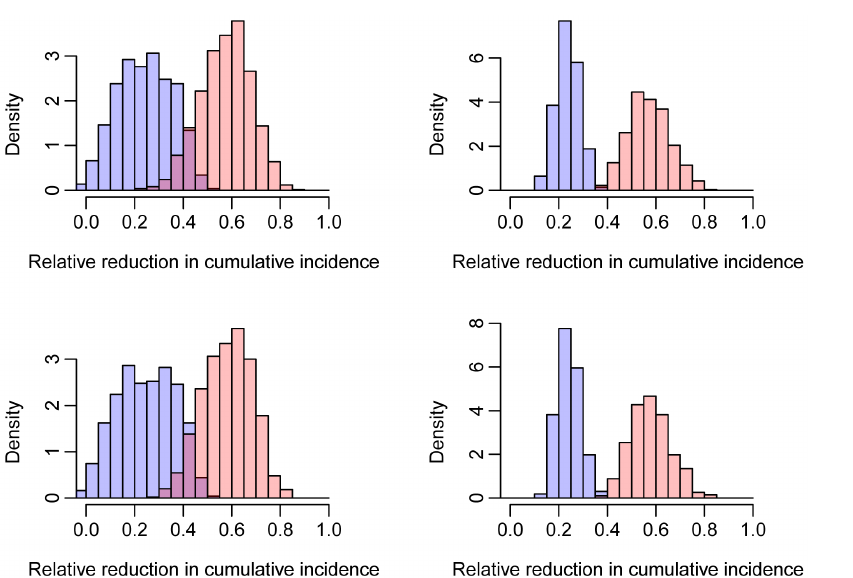
Figure 4. Uncertainty on the trial outcome in Zambia (top panels) and South Africa (bottom panels). The red and blue histograms show the relative reduction in 3-year cumulative incidence in arms A and B respectively when parameters vary within ranges shown in Table 1. The left panels show results obtained when all parameters are varied, and the right panels when assuming no population-level behavioural changes associated with the intervention.